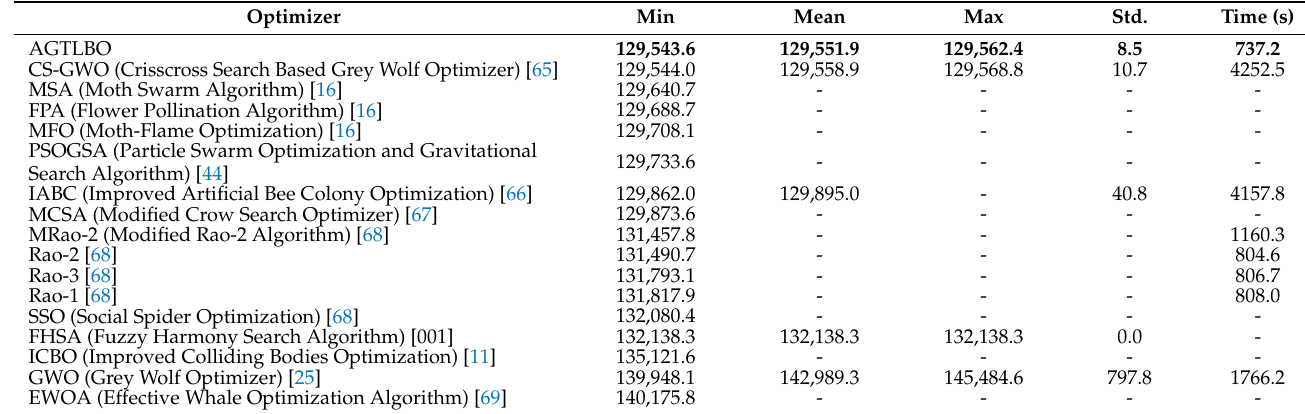
Table 17. Optimal results for Case